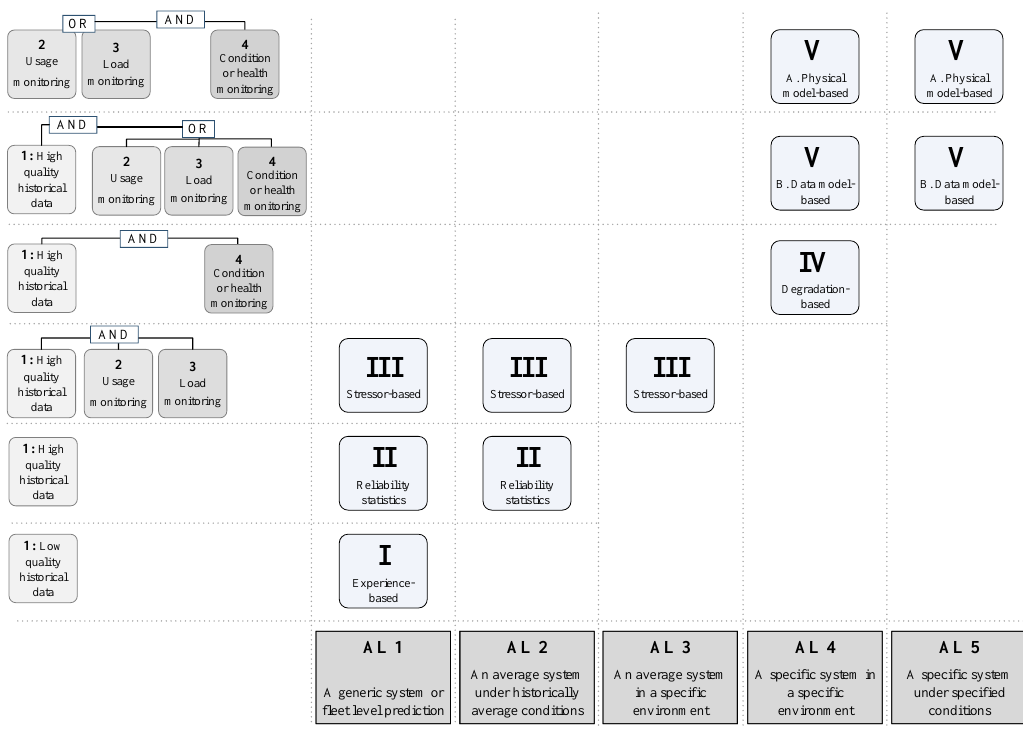
Figure 4. Mapping the preventive maintenance approaches to the ambition levels and data types.